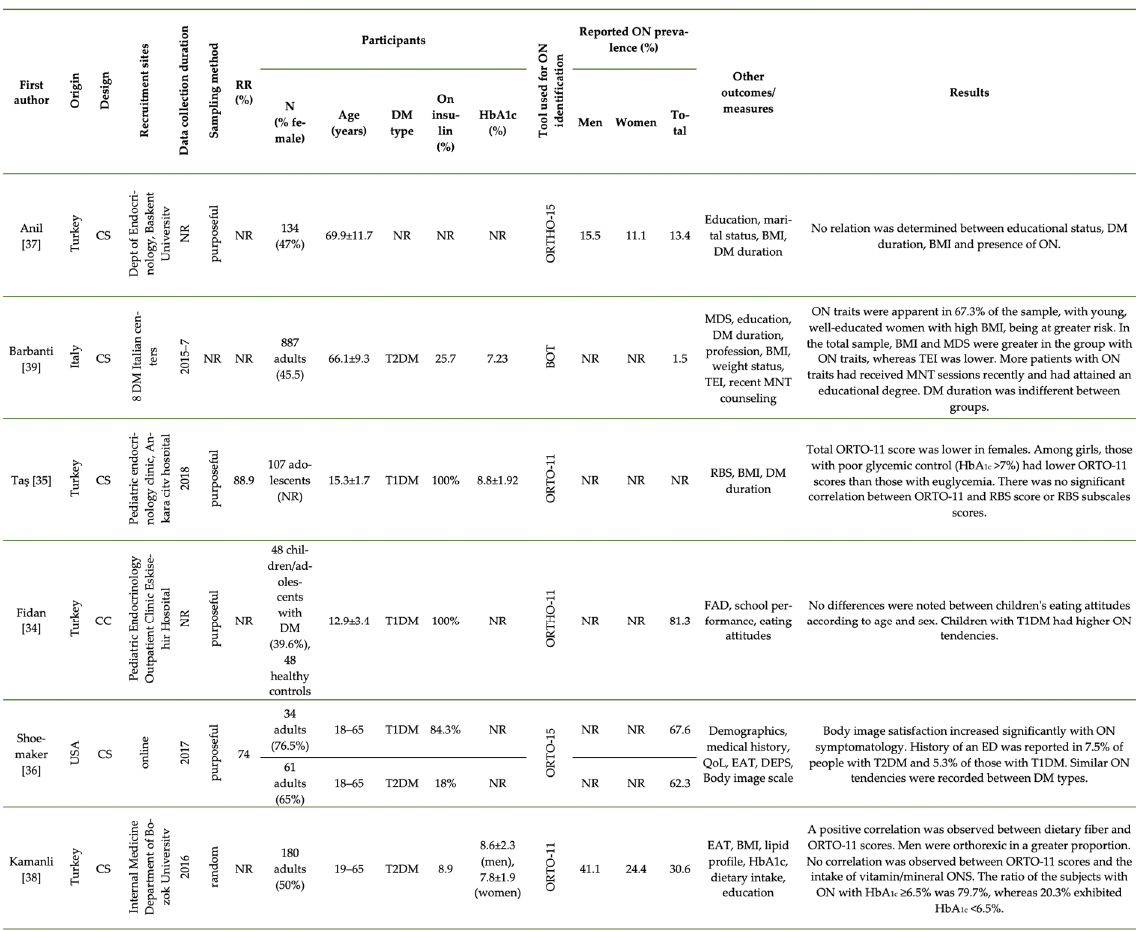
Figure 3. Primary studies assessing ON among patients with DM. BMI, Body Mass Index; BOT, Bratman Orthorexia Scale [2]; CC, case-control; CS, cross-sectional; DEPS, Diabetes Eating Problem Survey; DM, Diabetes Mellitus; EAT, Eating Attitudes Test; ED, eating disorder; FAD, family assessment device; HbA 1c , glycosylated hemoglobin; MDS, Mediterranean diet score; MNT, medical nutrition therapy; NOD, not other defined; NR, not reported; ON, orthorexia nervosa; ONS, oral nutrient supplements; ORTO, orthorexia questionnaire [40]; QoL, quality of life; RBS, Risk Behavior Scale; T1DM, Type 1 Diabetes Mellitus; T2DM, Type 2 Diabetes Mellitus; TEI, total energy intake.